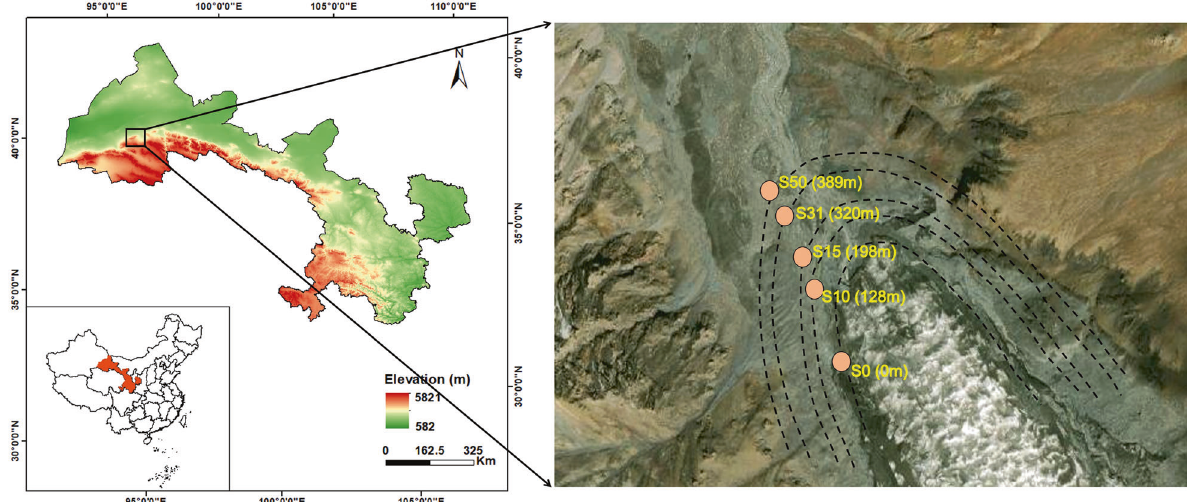
Fig. 1 Location of Laohugou Glacier No. 12 within China and the position of the sampling sites in the glacier foreland. Numbers in the fi ve sampling sites represent the retreat years (S0, S10, S15, S31, and S50). Numbers in brackets represent their distances from the ice